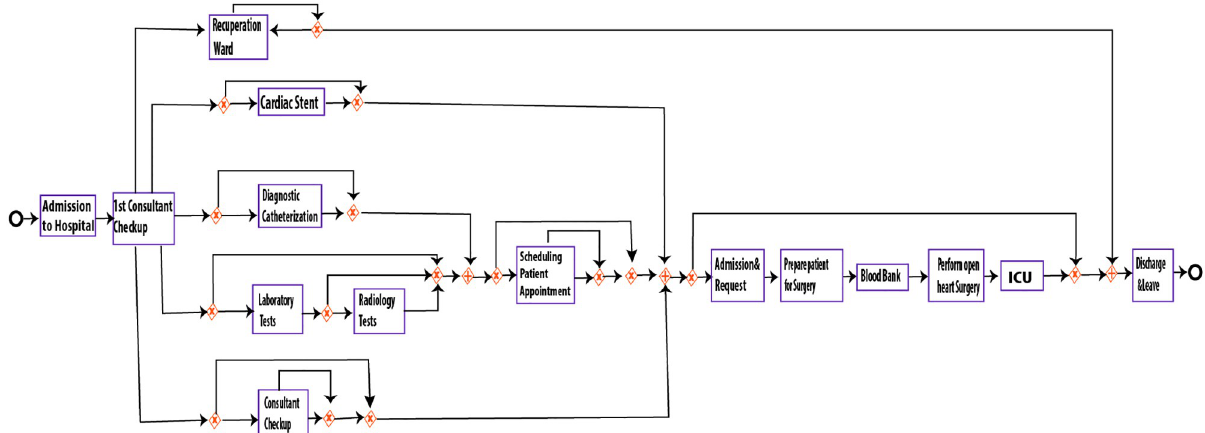
Fig 4. General business model for the heart surgeries in the hospital.